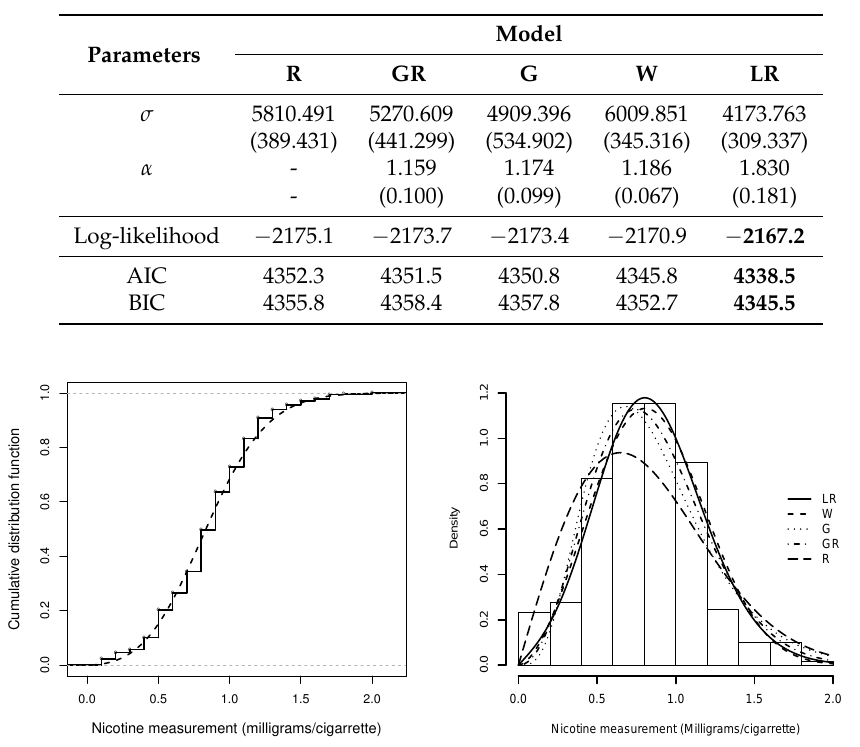
Figure 4. Left panel: Empirical cdf (solid line) for nicotine measurement data and the fitted LR distribution (dashed line). Right panel: Histogram of nicotine measurement data and fitted density functions.